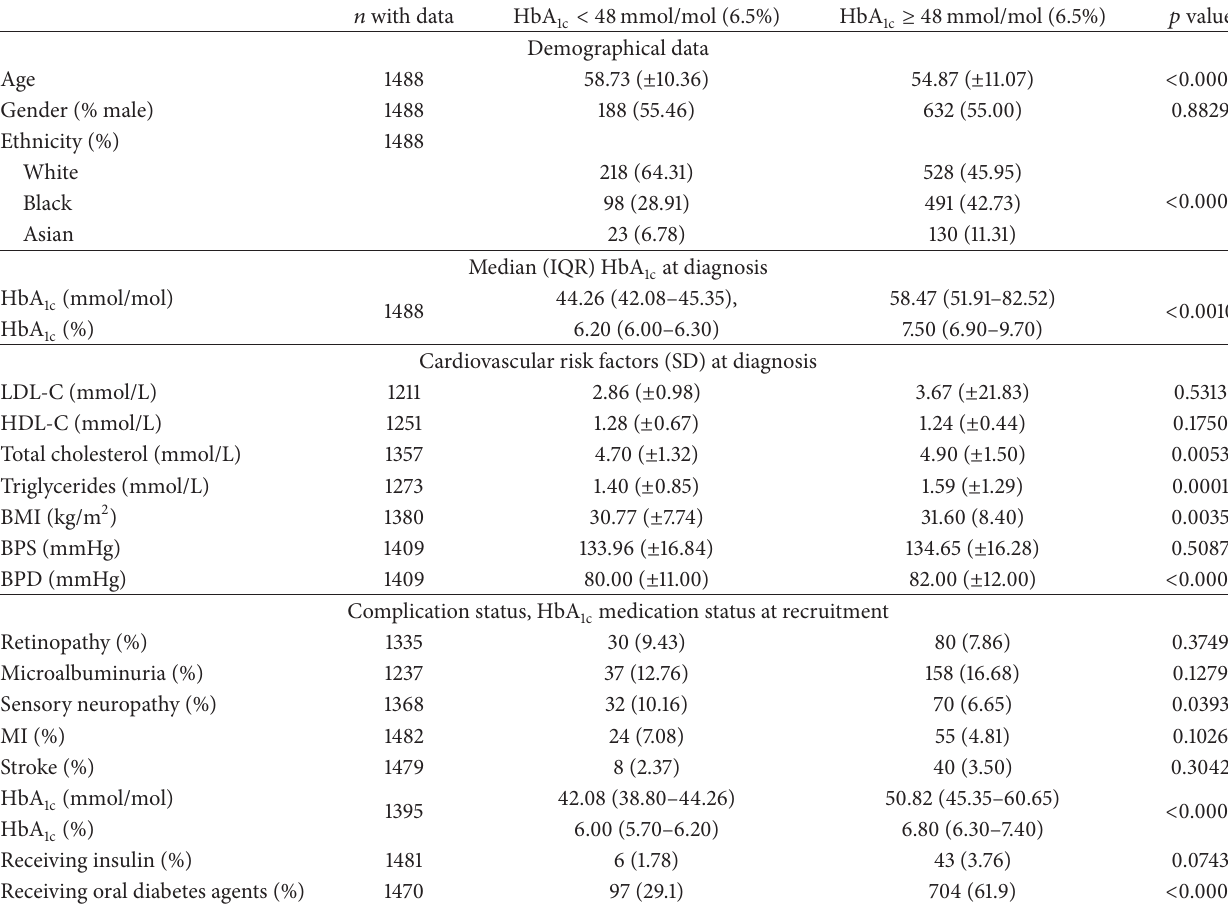
Table 1: Comparisons between participants diagnosed with HbA ment.